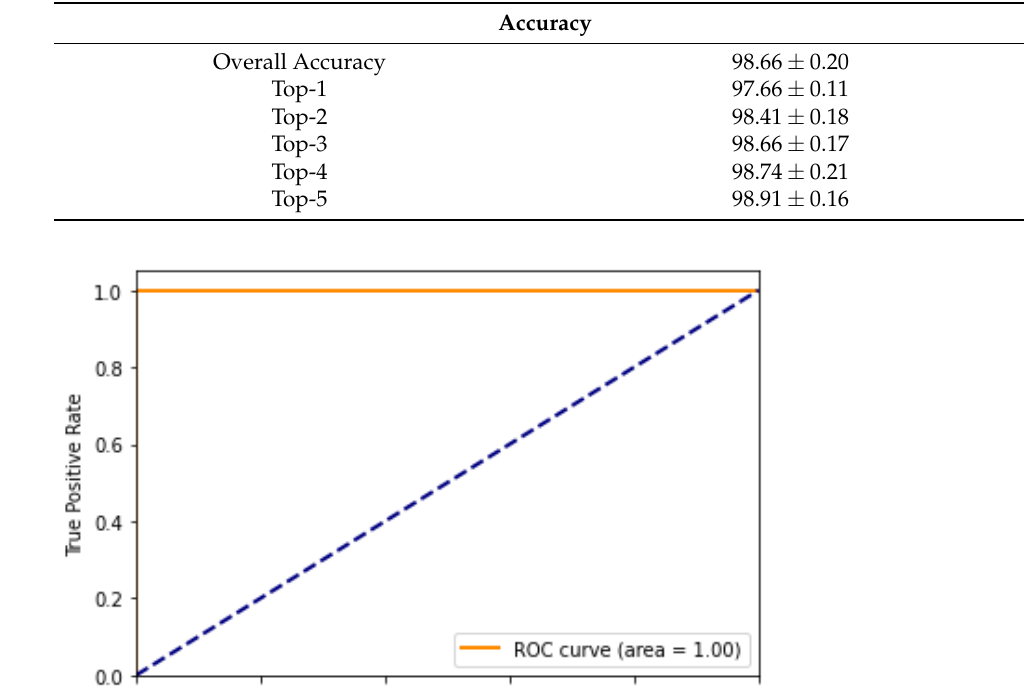
Table 6. The accuracy of the proposed system on the first session dataset with 50% for training and 50% for testing.